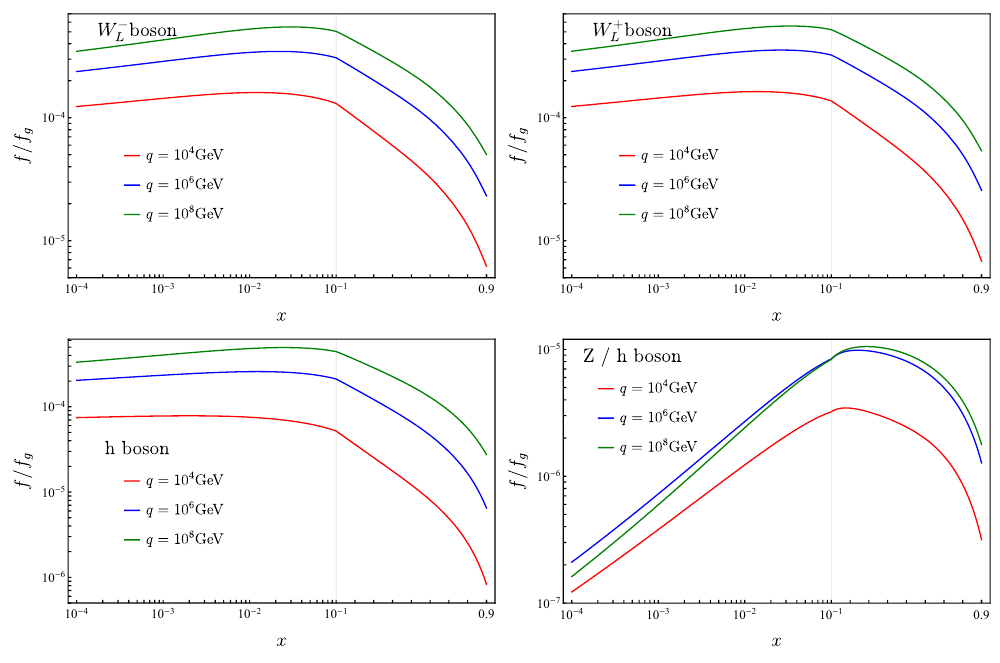
Figure 4 . Longitudinal gauge and Higgs bosons PDFs normalized by the gluon PDF. The Z L PDF is the same as the h PDF. The hZ L PDF is purely imaginary and we show the result divided by i . The thin gray line shows where the scales on the x- and/or y-axes switch between linear and logarithmic.